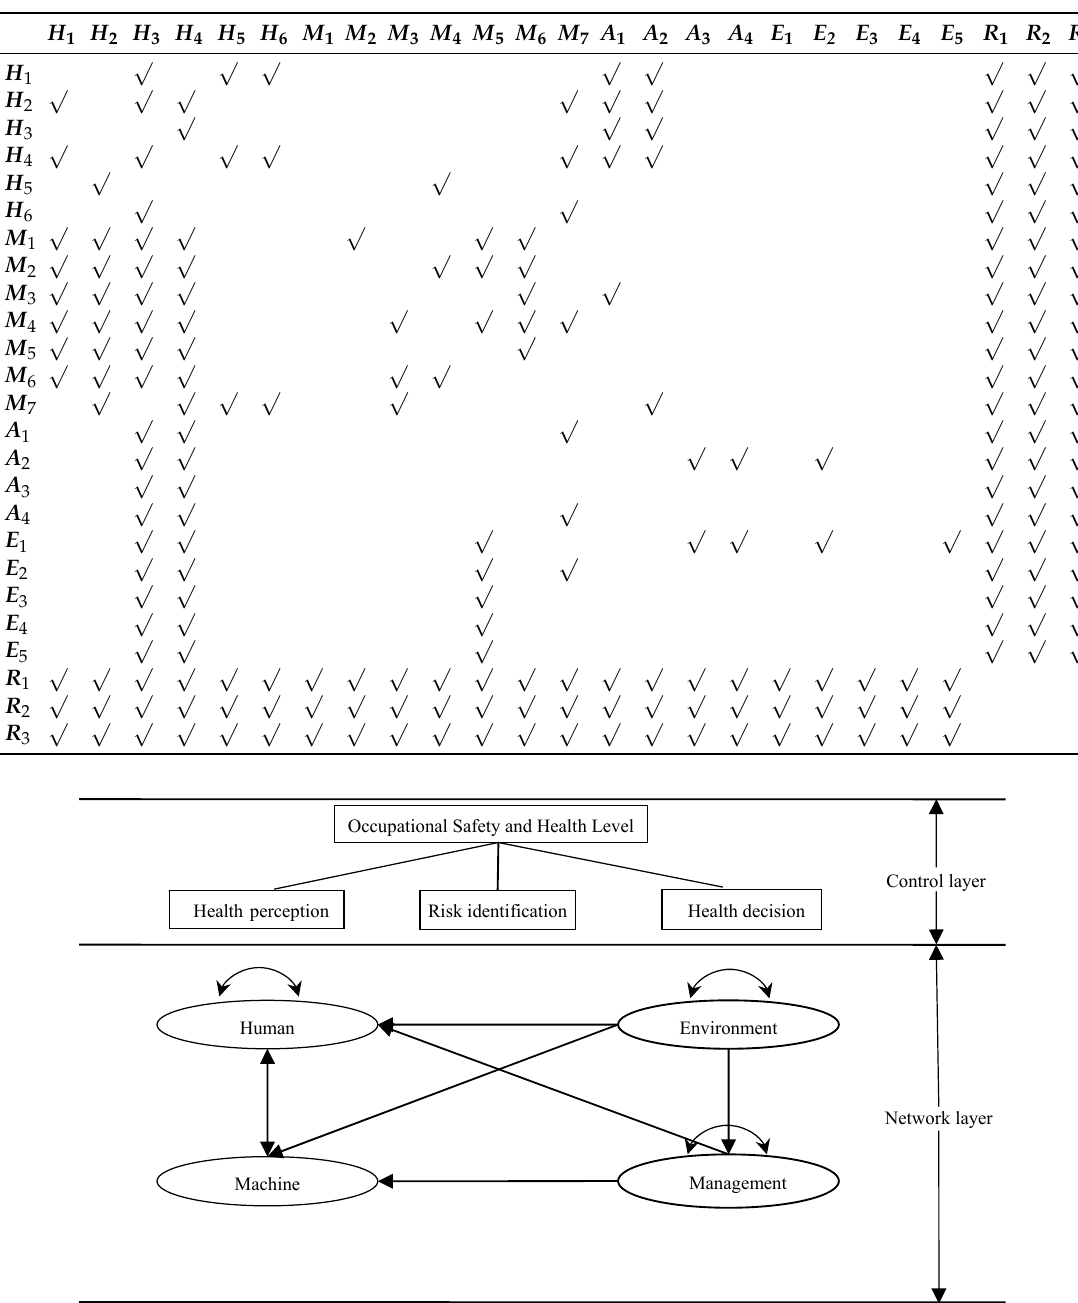
Table 2. Association of influencing factors of OSH.